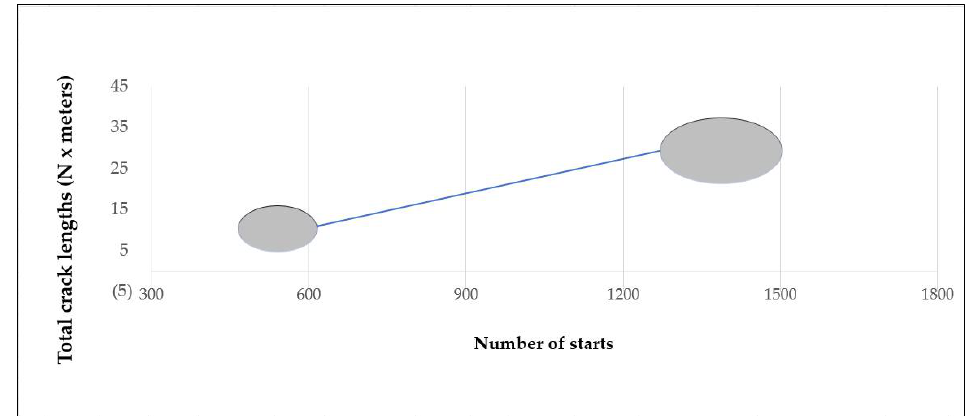
Figure 1. Impact of cycling on components’ cracking. Adapted from Ref. [45].